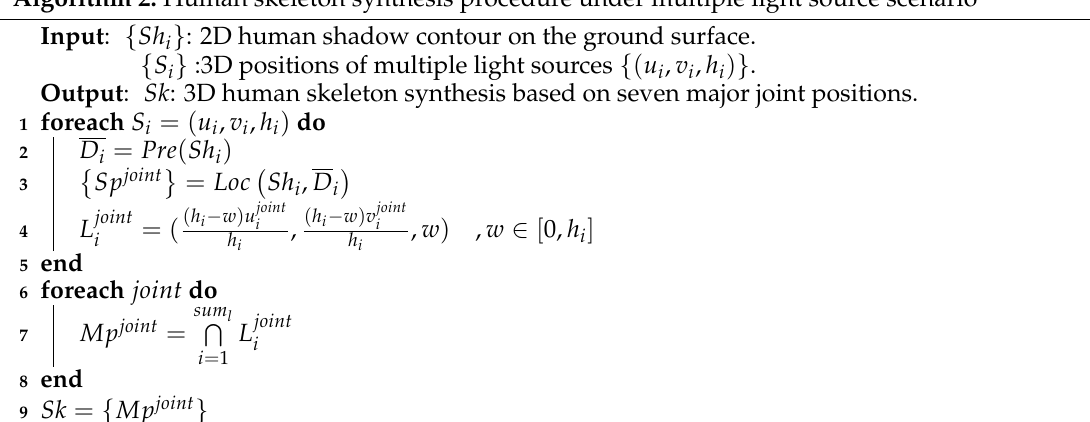
Figure 3. Demo of SSSE in a multiple light source scenario: ( a ) A simulated dual light source scenario. Sp neck a and Sp neck a are the joint areas of the neck position in the shadows projected by light source a and b , respectively. Similarly, light beams L neck a and L neck are generated by light sources a and b , respectively. b The enclosure Mp neck is the intersection area of L neck a and L neck . ( b ) Scenario reconstruction. b Algorithm 2: Human skeleton synthesis procedure under multiple light source